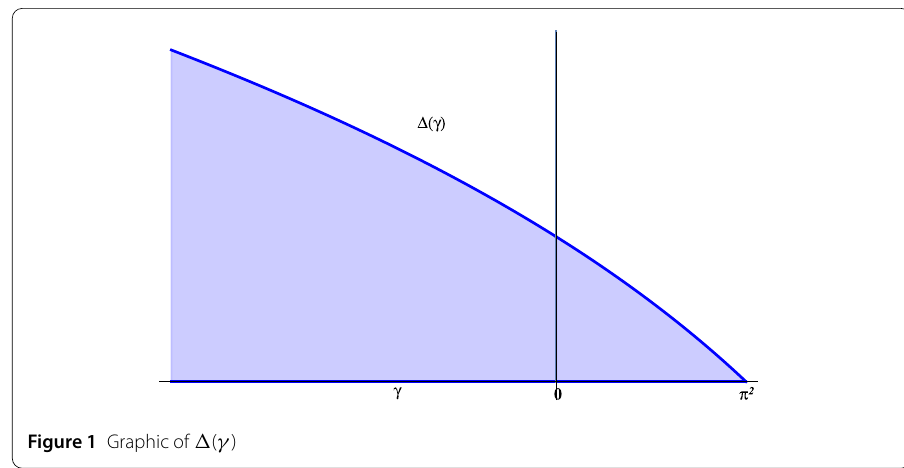
Figure 1 Graphic of (cid:8) ( γ